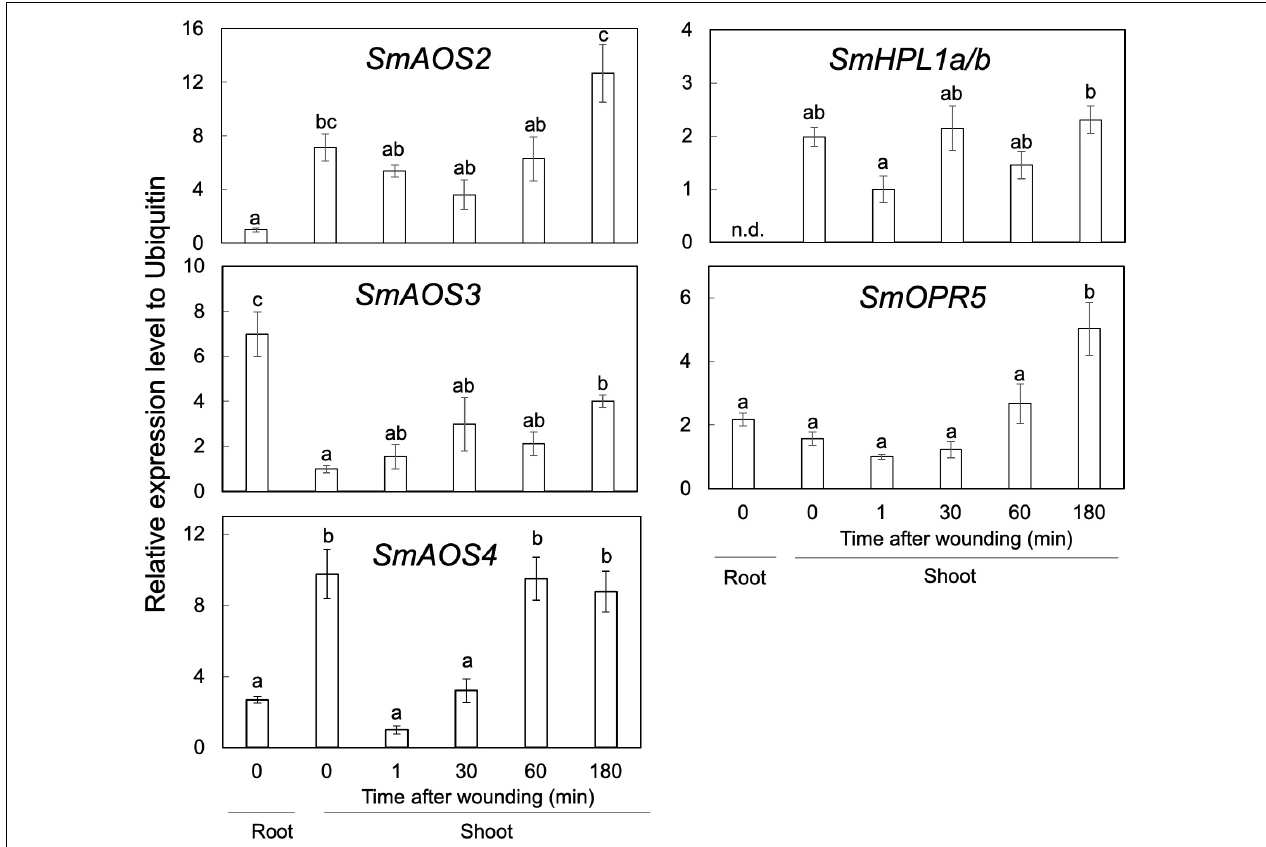
FIGURE 6 | Gene-expression profiles of SmAOS2 , SmAOS3 , SmAOS4 , SmHPL1a/b , and SmOPR5 in the roots and the shoots. Those in the shoots after mechanical wounding are also shown. The expression data represent the mean ± standard error of four biological replicates. Different letters indicate significant difference ( P < 0.05, one-way ANOVA, Tukey-Kramer). n.d., not